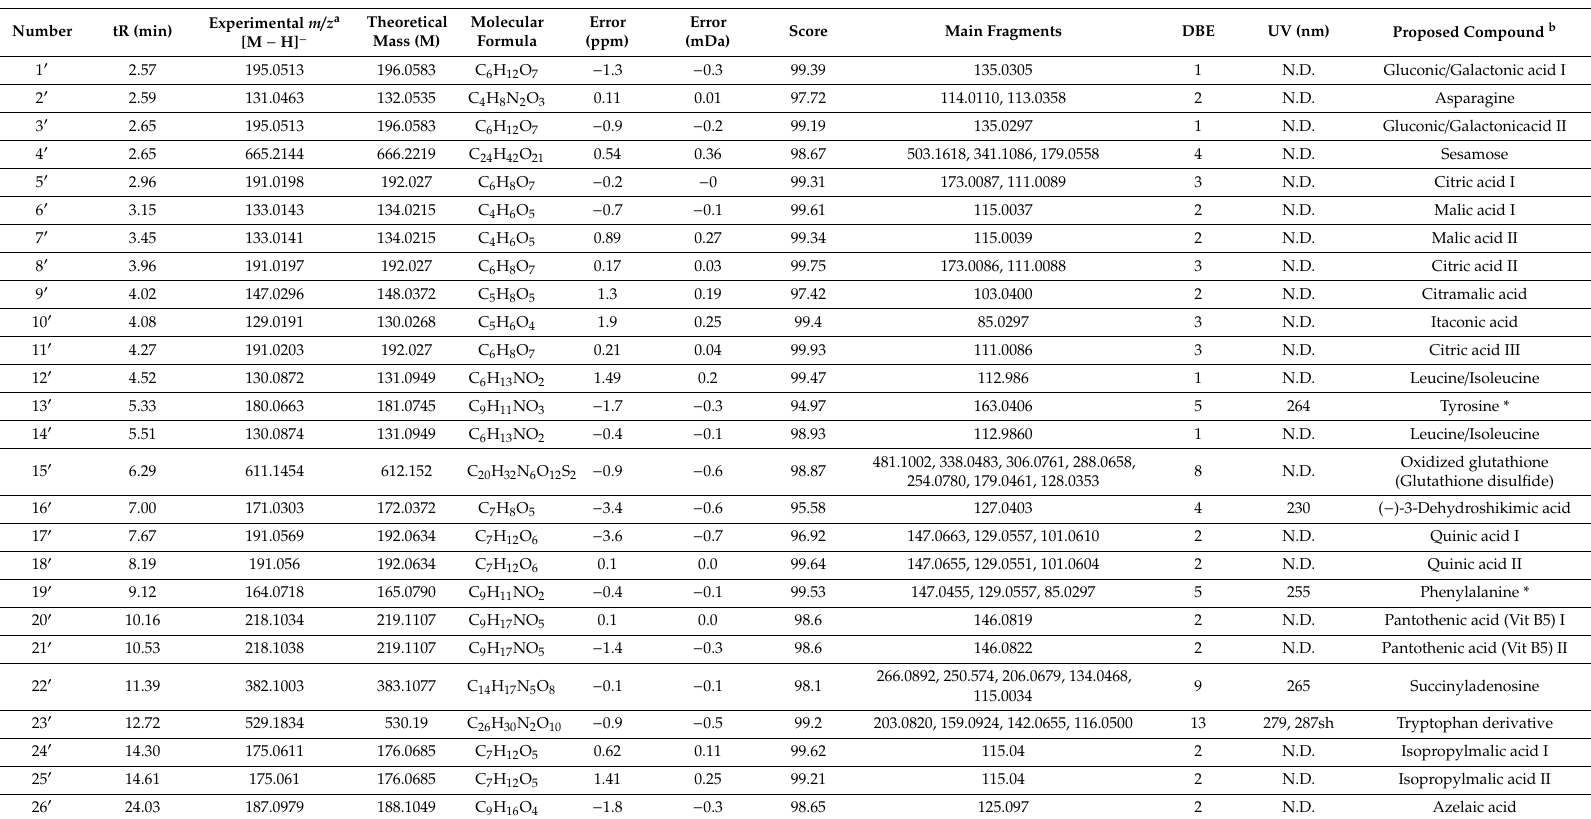
Table 2. Non-phenolic compounds characterized in the cake of the Egyptian cultivar of Sesamum indicum L. ‘Giza